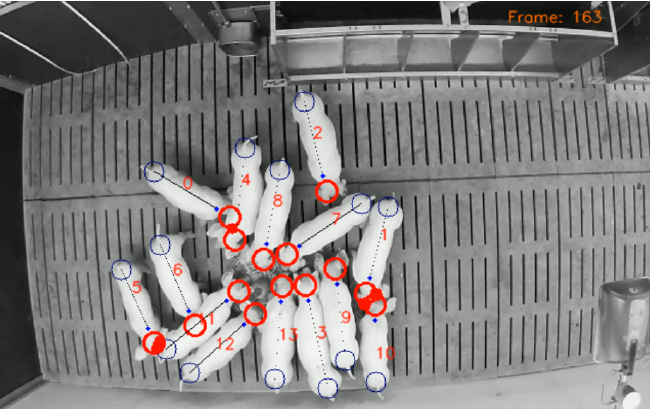
Figure 7. Based on the KF estimates, a region of interest for each head and tail area is computed. By detecting the intersection of at least two regions, the type of contact and the associated animals can be identified. Exemplarily, a head–tail contact can be detected between pigs 5 and 11 and a head–head contact for pigs 1 and